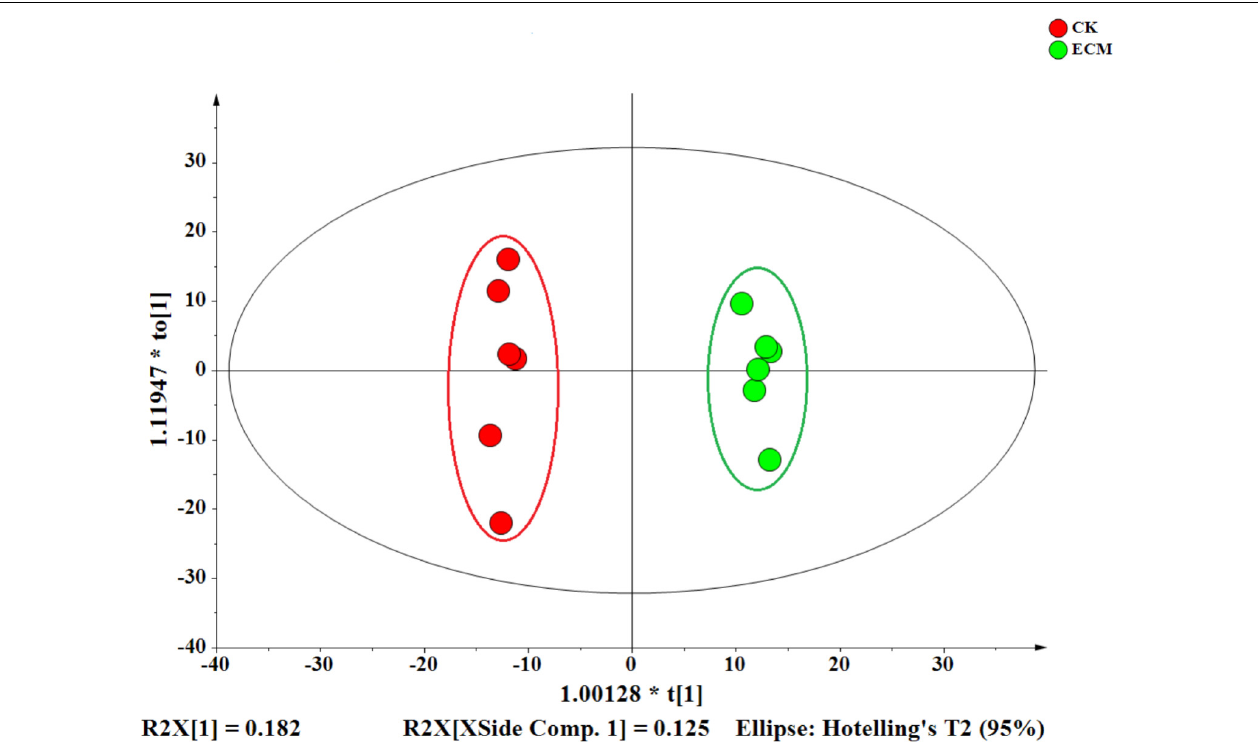
FIGURE 8 | Orthogonal-partial least squares-discriminant analysis (OPLS-DA) of the metabolites in the ectomycorrhiza and control roots. The OPLS-DA score plot was generated from all of the 14704 metabolites detectedin different